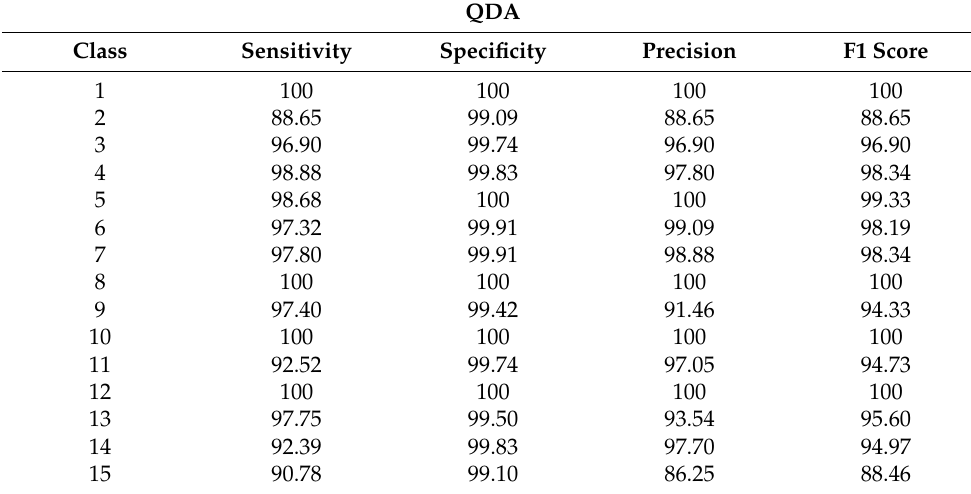
Table 11. Average of the statistical parameters for the eight subjects evaluated individually.